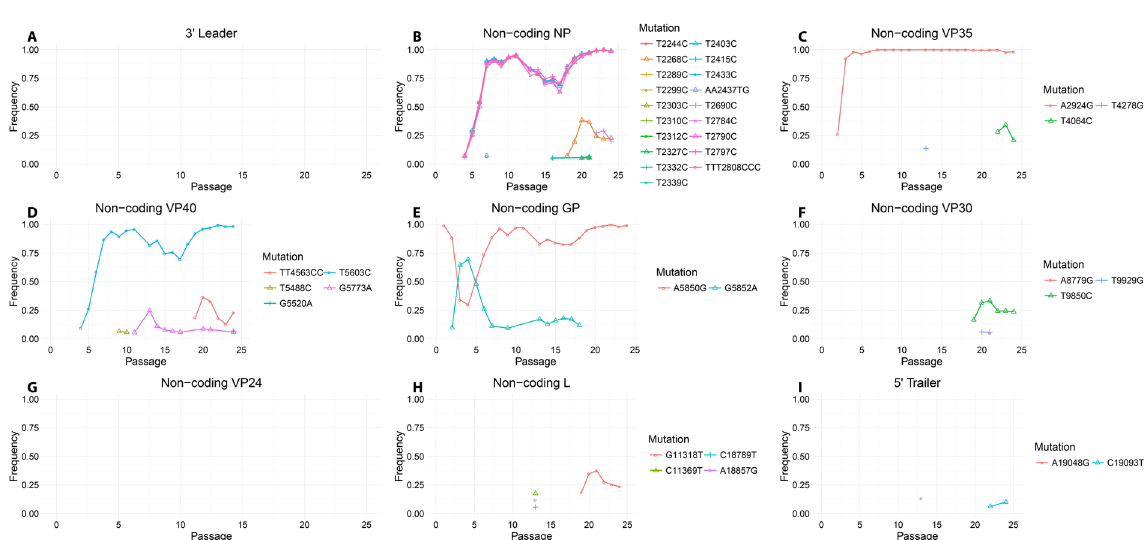
Figure 3. Mutations in non-coding regions over virus passages in SCID mice. Frequency of reads containing a mutation over depth as a function of passage for the following non-coding regions: ( A ) 3 ′ leader; ( B ) NP; ( C ) VP35; ( D ) VP40; ( E ) GP; ( F ) VP30; ( G ) VP24; ( H ) L; and ( I ) 5 ′ trailer. For each protein, the mutations are colored from the most 3 ′ (Red) to the most 5 ′